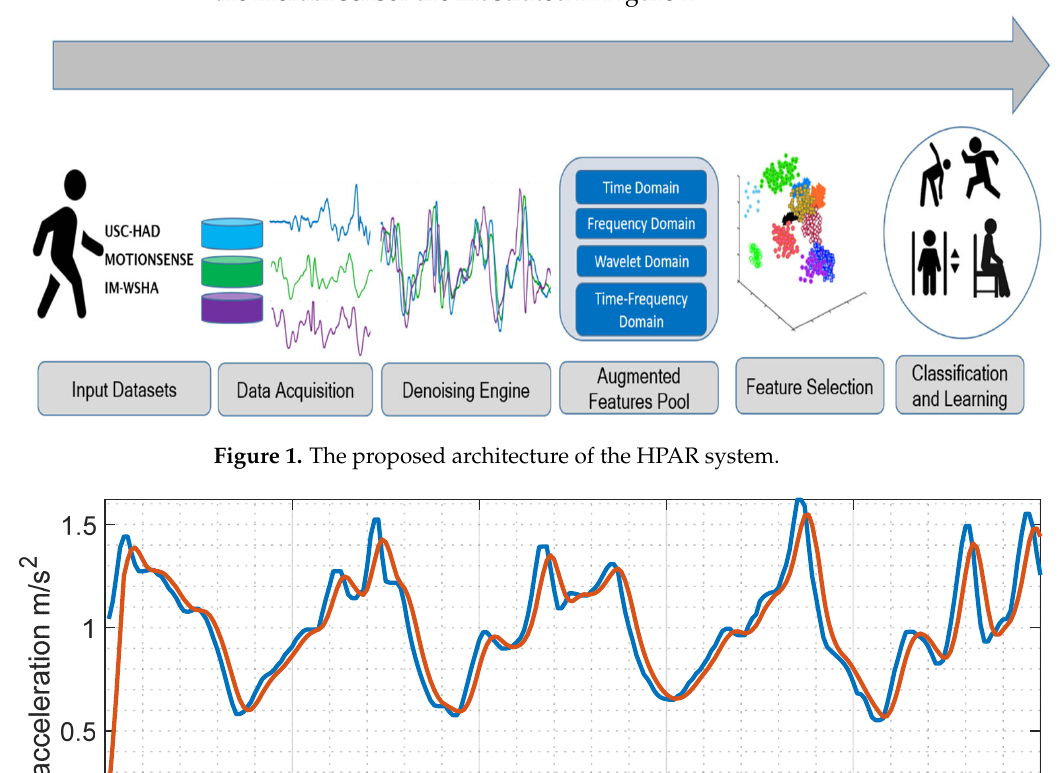
Figure 1. The proposed architecture of the HPAR system.